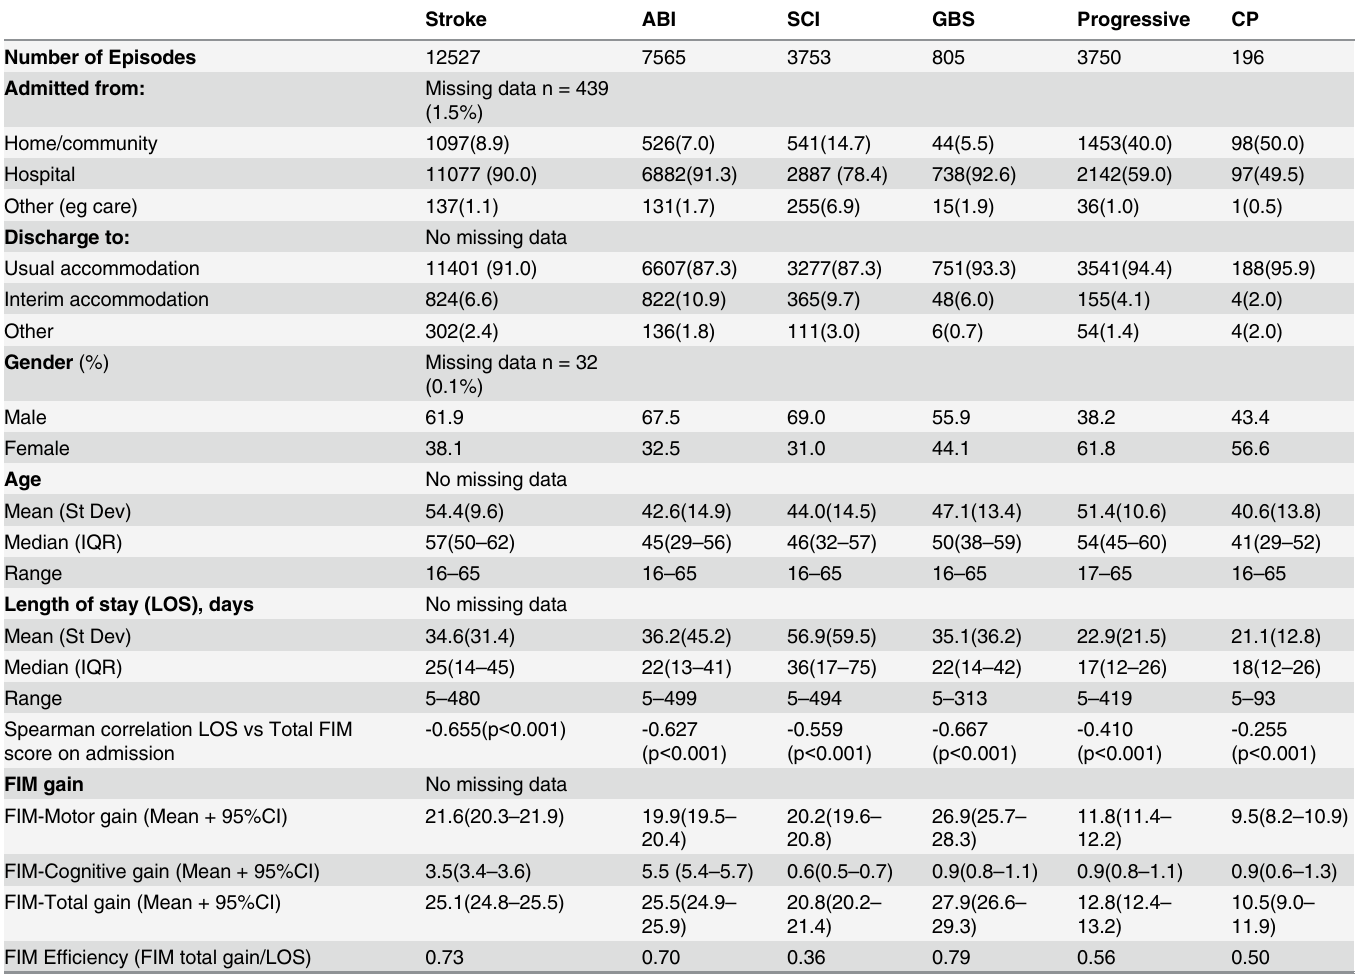
Table 4. Demographics within the six groups for the complete episodes (n =